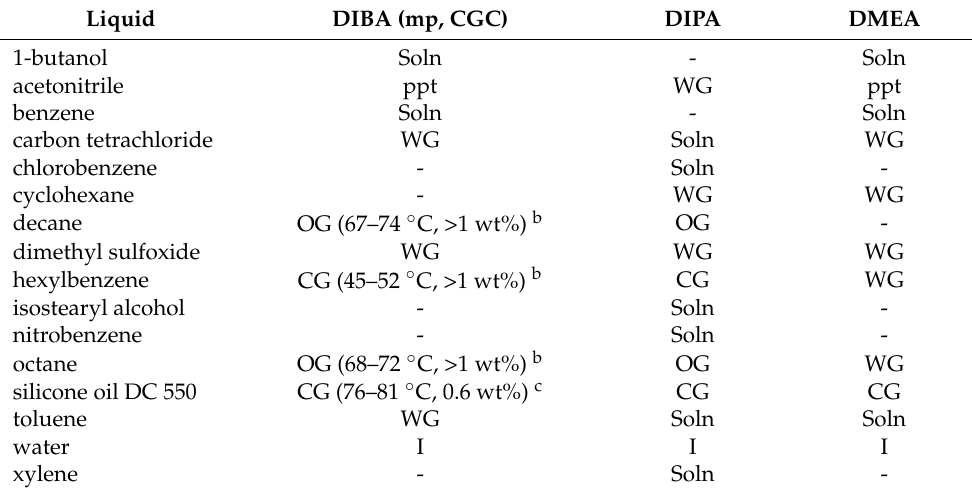
Table 1. Sample appearances of 2 wt% DIBA, DIPA, and DMEA in various liquids a and melting point ranges (mps), and critical gelator concentrations (CGCs) of the 2 wt% DIBA samples.